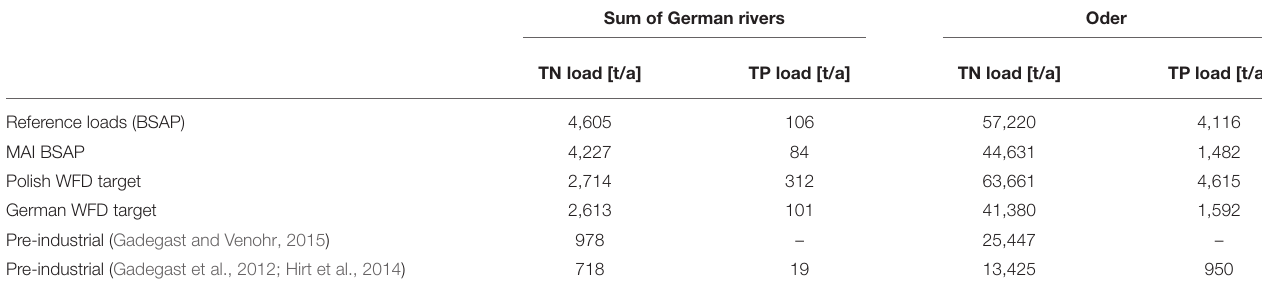
TABLE 2 | Flow-normalized loads to Szczecin Lagoon for the reference period of BSAP (1997–2003) and load targets according to HELCOM Baltic Sea Action Plan (HELCOM, 2013b); loads calculated with adoption of the Polish WFD target (Garcia et al., 2012) and the German WFD-target (BLANO, 2014); estimated pre-industrial loads from catchment model